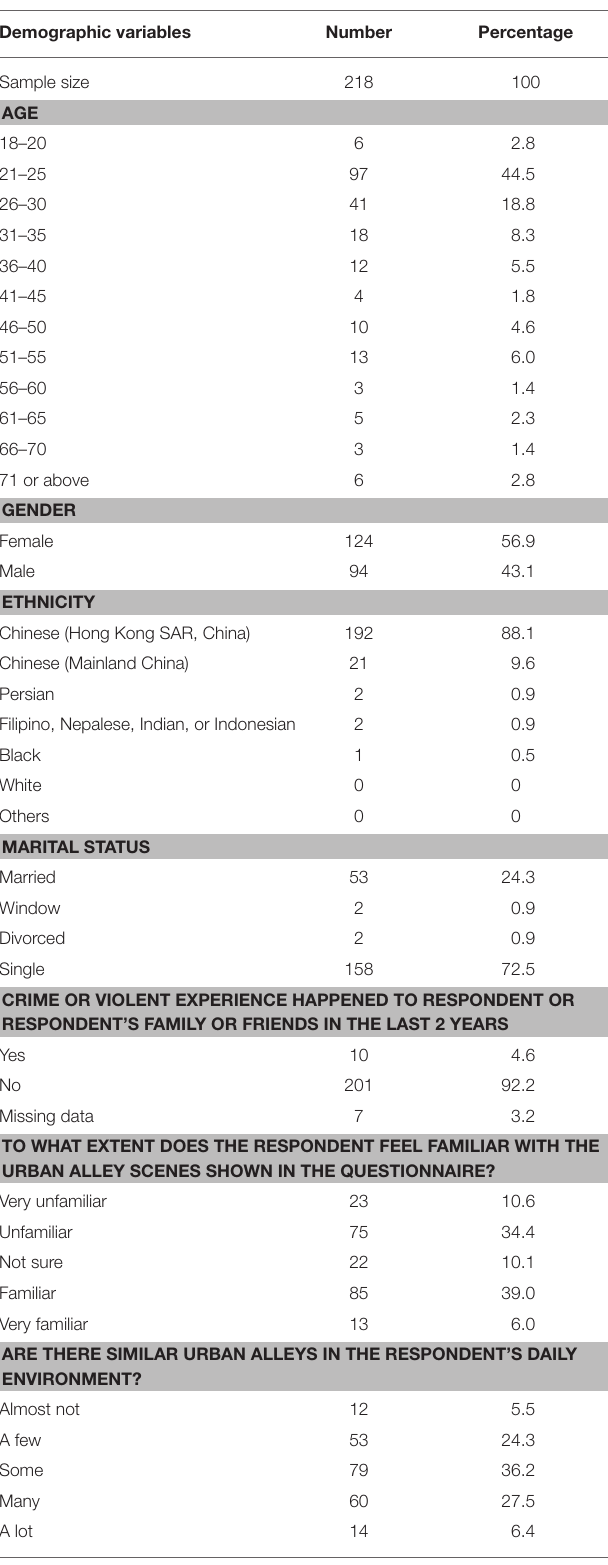
TABLE 1 | Sample socio-demographic characteristics for participants. safety? Table 2 and Figure 5 show the average perceived safety of the baseline scene and the 15 intervention scenes. In general, safety, compared to the baseline ( p <